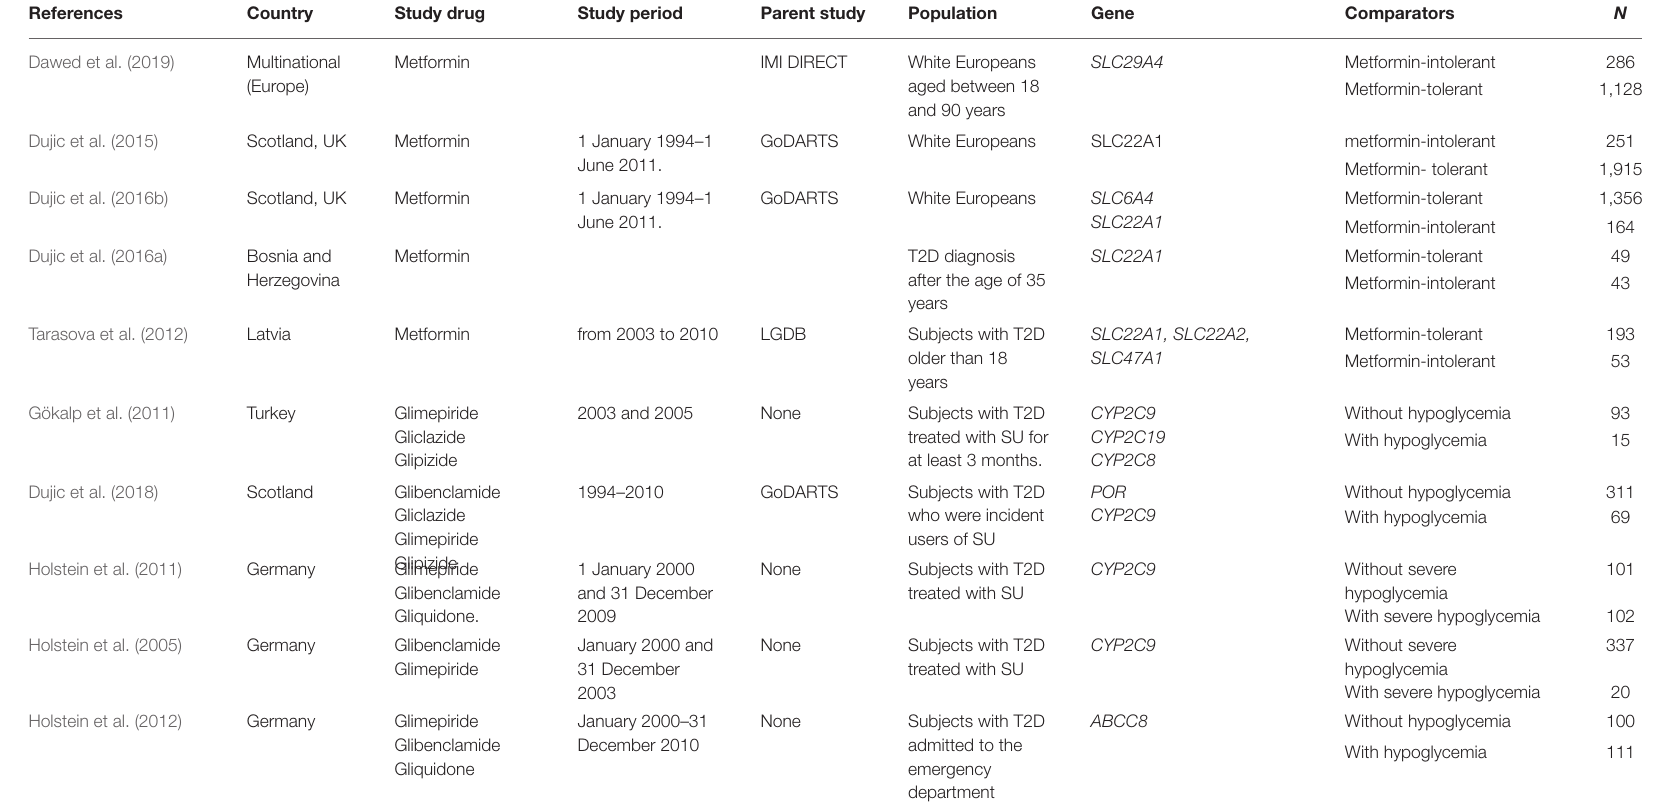
TABLE 2 | Description of included